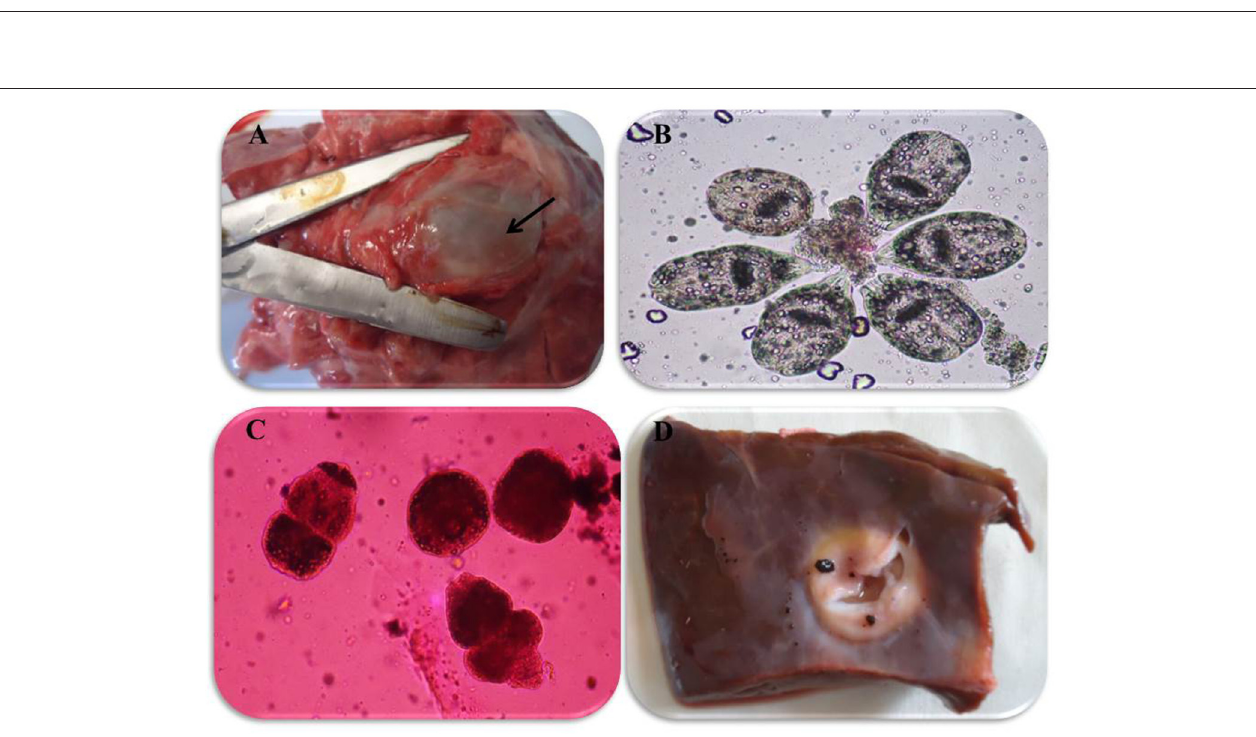
FIGURE 2 | Morphological appearance of hydatid cyst in lung and liver of cattle. (A) Solitary viable fertile hydatid cysts in the lung of cattle. (B) Multiple scolices in viable fertile hydatid cyst in the lung of cattle using 0.1% eosin stain (X100). (C) Multiple scolices in non-viable fertile hydatid cyst in the lung of cattle using 0.1% eosin stain (X100) and (D) calcified hydatid cysts in the liver of cattle.